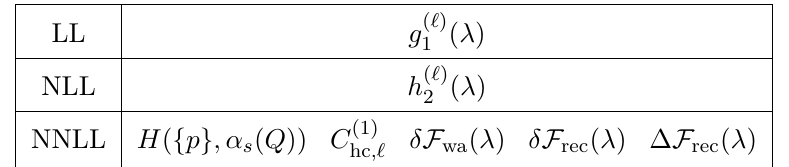
Table 1 . The various contributions in the expansion of the resummation that are amenable to validation against EVENT2.